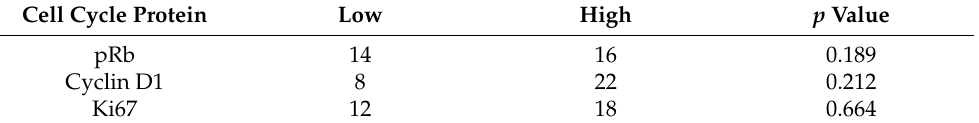
Table 3. Follow-up information for 30 horses with sarcoids, according to cell cycle protein expression.